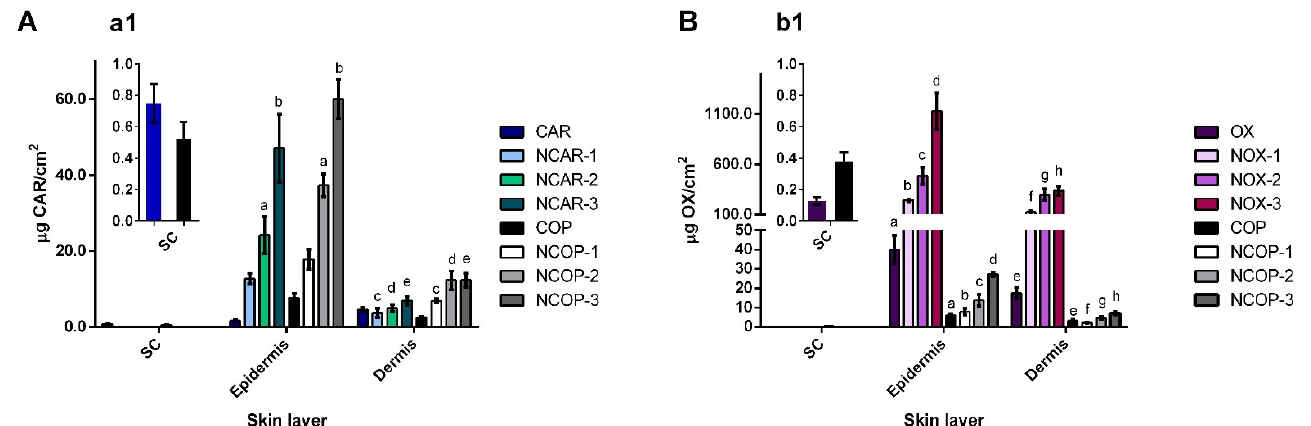
Figure 3. Cumulative amount permeated ( µ g/cm 2 ) of β -caryophyllene (CAR) ( A ) and caryophyllene oxide (OX) ( B ) in skin layers with detailed permeation in the stratum corneum ( a1 , b1 ). The presence of CAR and OX was not detected in the samples of receptor fluid. Same letters mean the statistical difference between groups (n = 6/group) with proportional amounts of CAR and OX in the oily core, performed by one-way ANOVA followed by Tukey’s post hoc test ( p < 0.001).